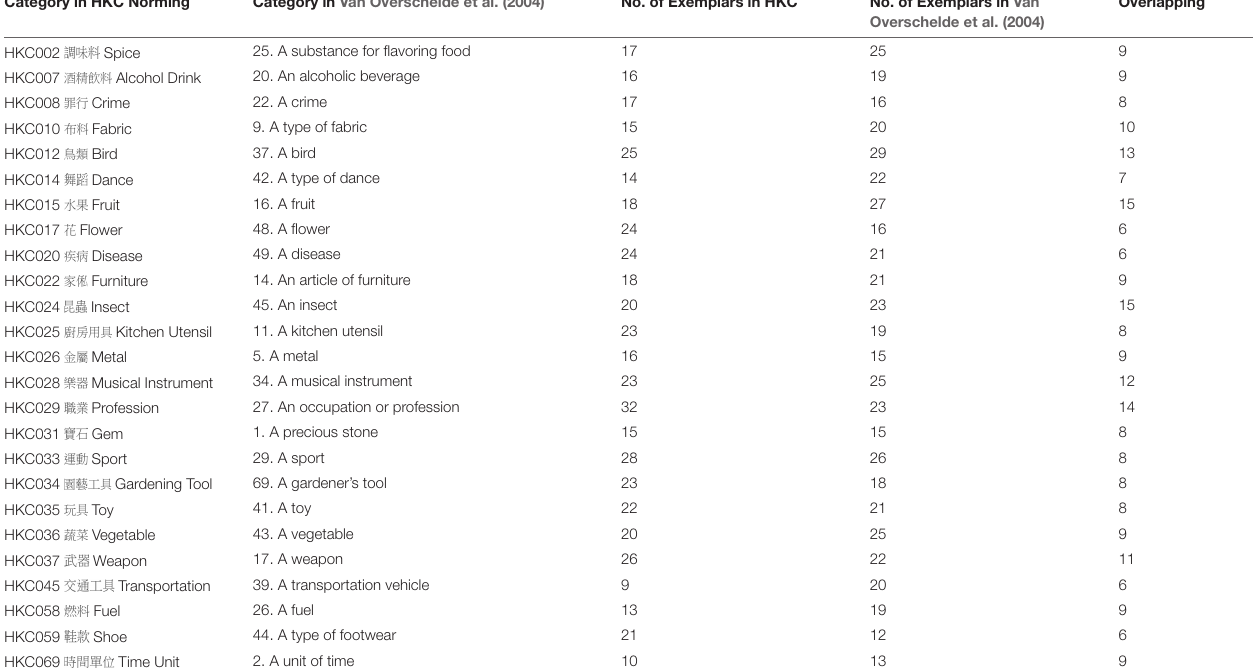
TABLE 5 | Comparison with the English norm of Van Overschelde et al. (2004) with list of mutually included categories. Category in HKC Norming Category in Van Overschelde et al.